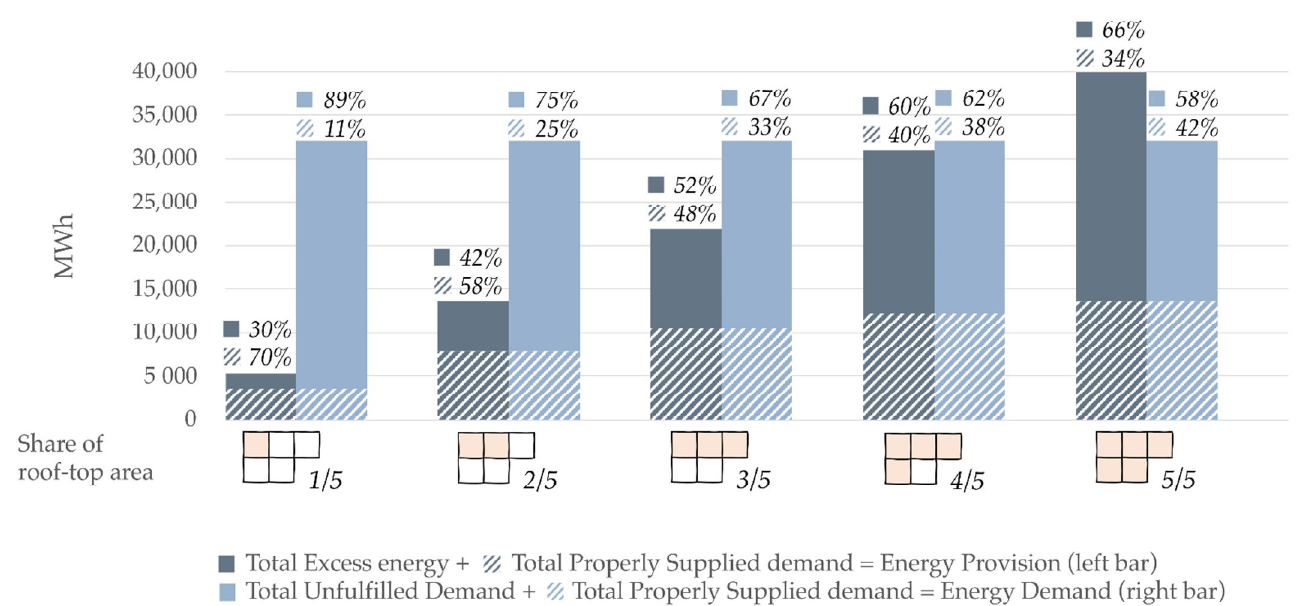
Figure 11. Spatiotemporal results of electricity demand and energy provision via photovoltaic systems, in the entire case study area (own